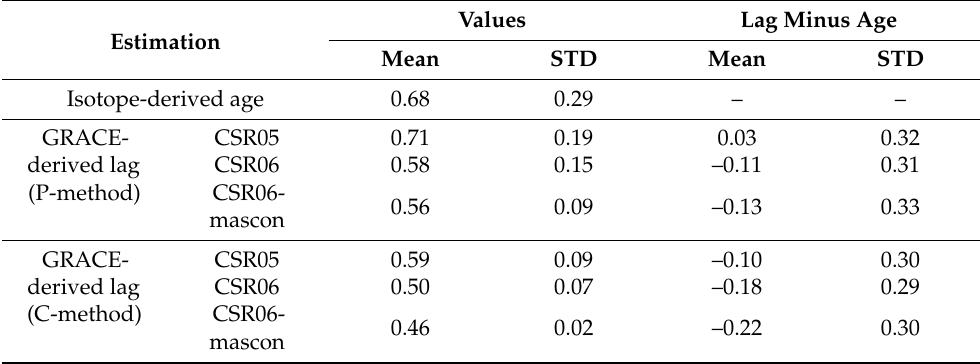
Table 3. The mean and standard deviation of the isotope-derived age, the GRACE-derived lag, and their difference using the P-method and the C-method. Values Lag Minus Age Estimation Mean STD Mean